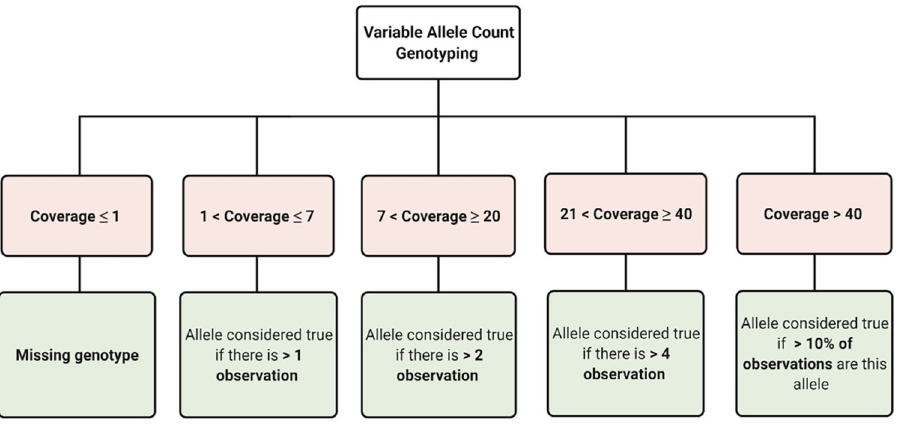
Fig 5. Variable allele count genotyping flow